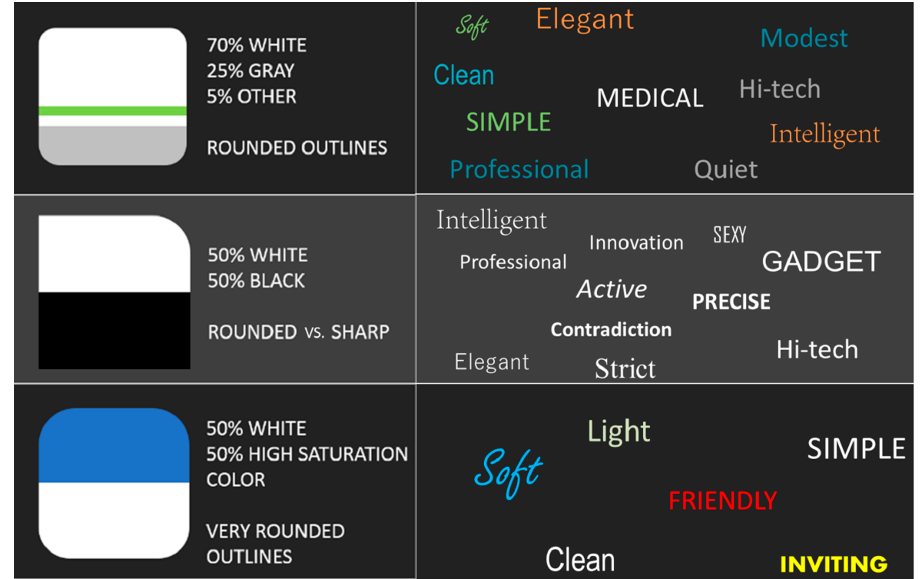
Figure 7. Abstract diagrams created to define guidelines for designing medical devices according to the desired user experience.